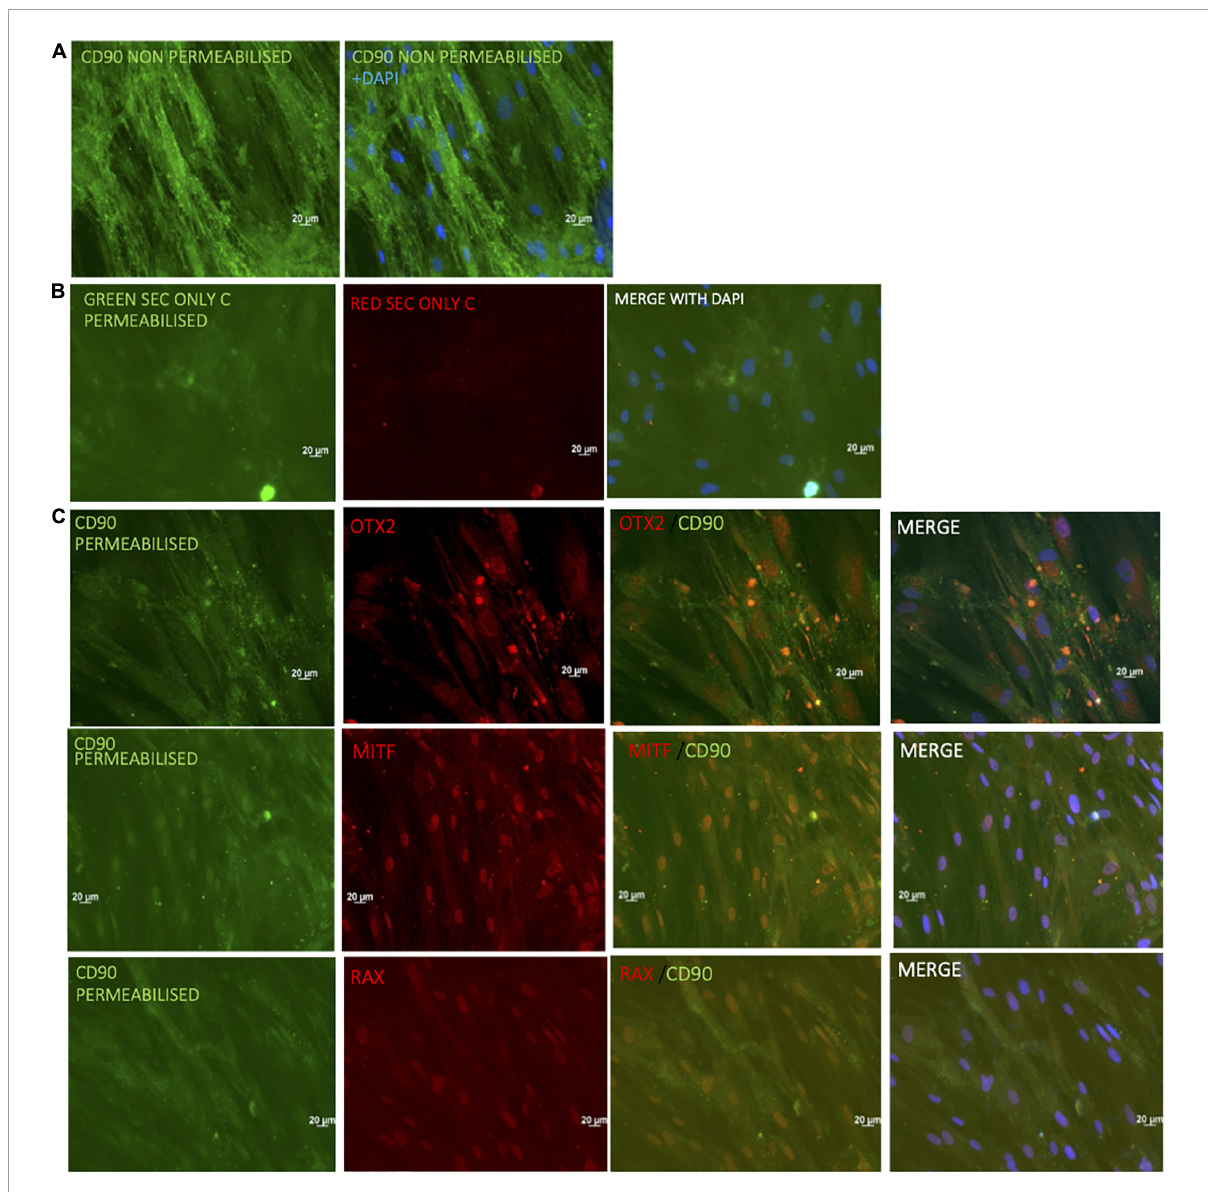
FIGURE5 Immunocytochemistry confirms CD90 expression in phDPSC acquiring retinal progenitor markers. Robust CD90 expression (green) is seen in untreated phDPSC cells by immunocytochemistry. (A) This panel shows signal strength when ICC is performed in the absence of permeabilization (to preserve the signal of cell surface marker CD90). (B) These panels show secondary only controls for red and green signals when ICC is performed with permeabilization to detect nuclear markers. (C) Expression of CD90 and early eye field transcription factors OTX2, MITF, and RAX in phDPSC treated to retinal differentiation conditions after 50 days in culture. The CD90 signal is quenched compared to A due to the permeabilization required to elicit signal from nuclear antigens OTX2, MITF, and RAX but can be compared to the secondary only control in B to assess the positivity of the signal. Despite the quenched signal, CD90 (green) is seen not only in control cells but in treated cells colocalizing with nuclear expression of OTX2, MITF, and